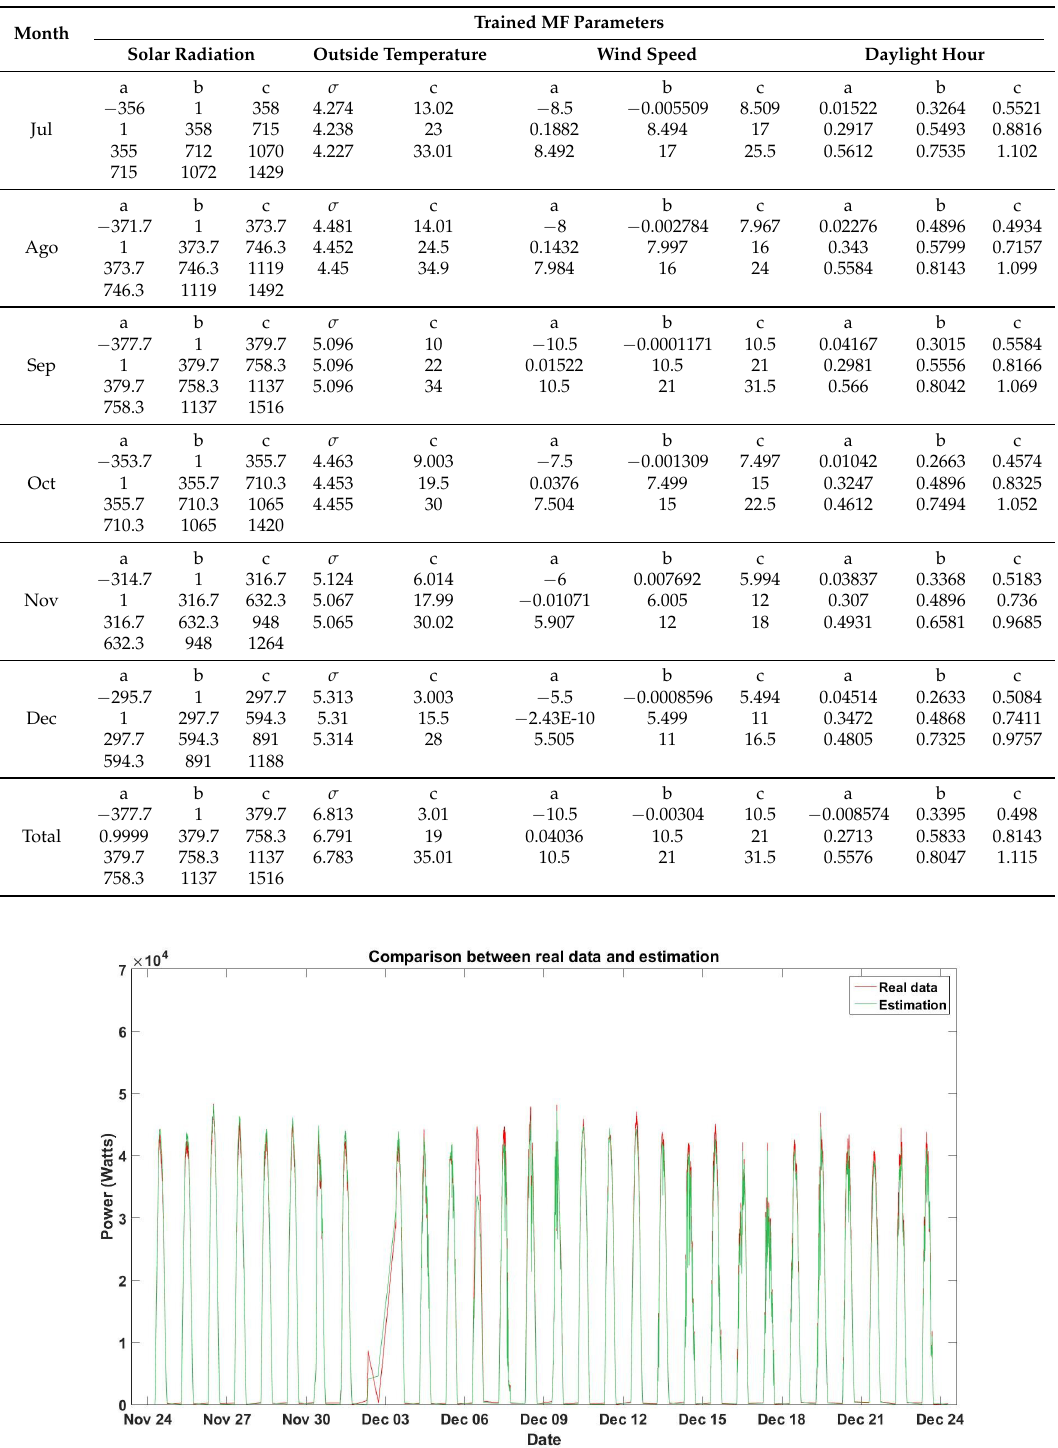
Table 4. Monthly and overall trained MF parameters for MCS.